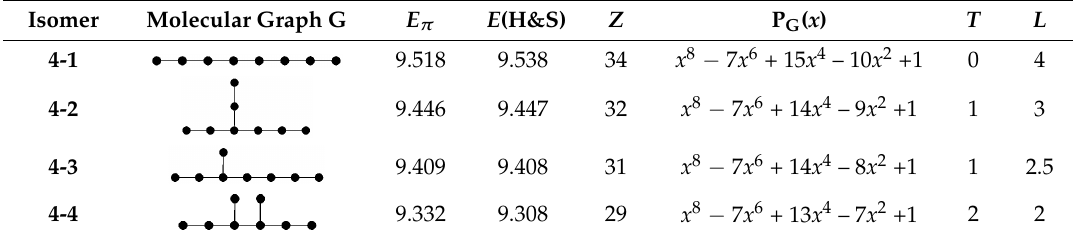
Table 2. Characteristic quantities of four isomers 4-1 ~ 4-4 of octatetraenes.